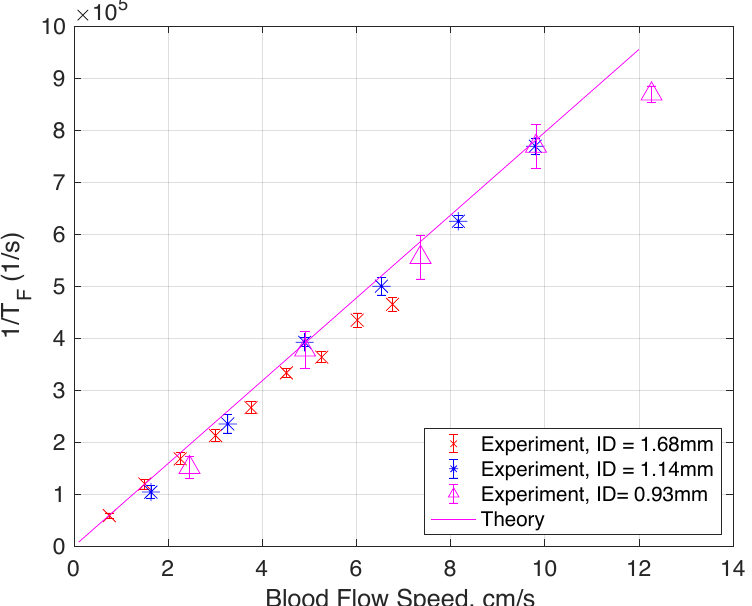
Figure 8. Comparison between theoretical calculations (from Equation (17) and experimentally measured decorrelation rates under different blood flow speeds and tube diameters. The scattered data set with the error bar represents the 95% confidence interval over 25 measurements. Each mea- surement took 1 s. The following parameters are used in the calculations: n = 1.36, µ (cid:48) in s = 1600 m − 1 and µ in a = 1000 m − 1 for deoxygenated blood